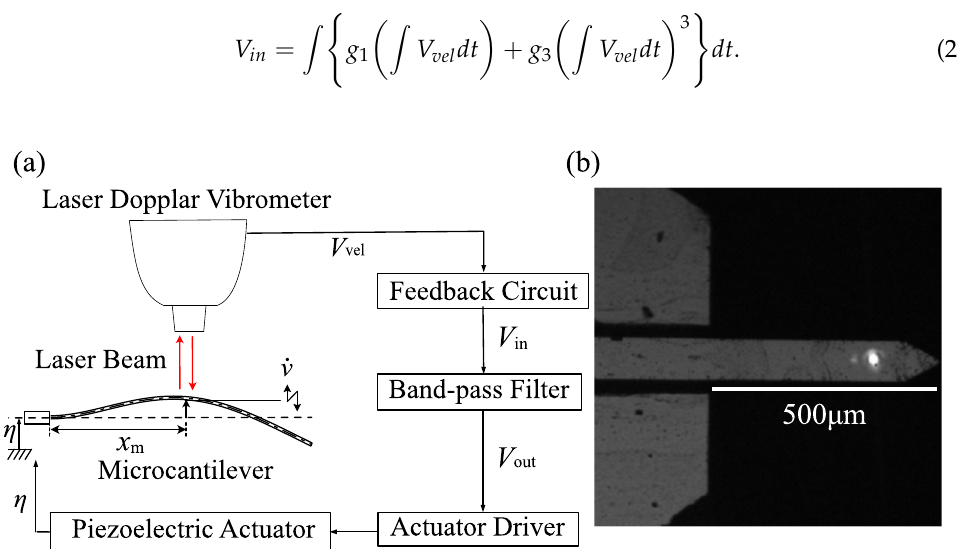
Figure 5. Experimental set-up: ( a ) signal flow in the experiment; ( b ) appearance of the microcan-